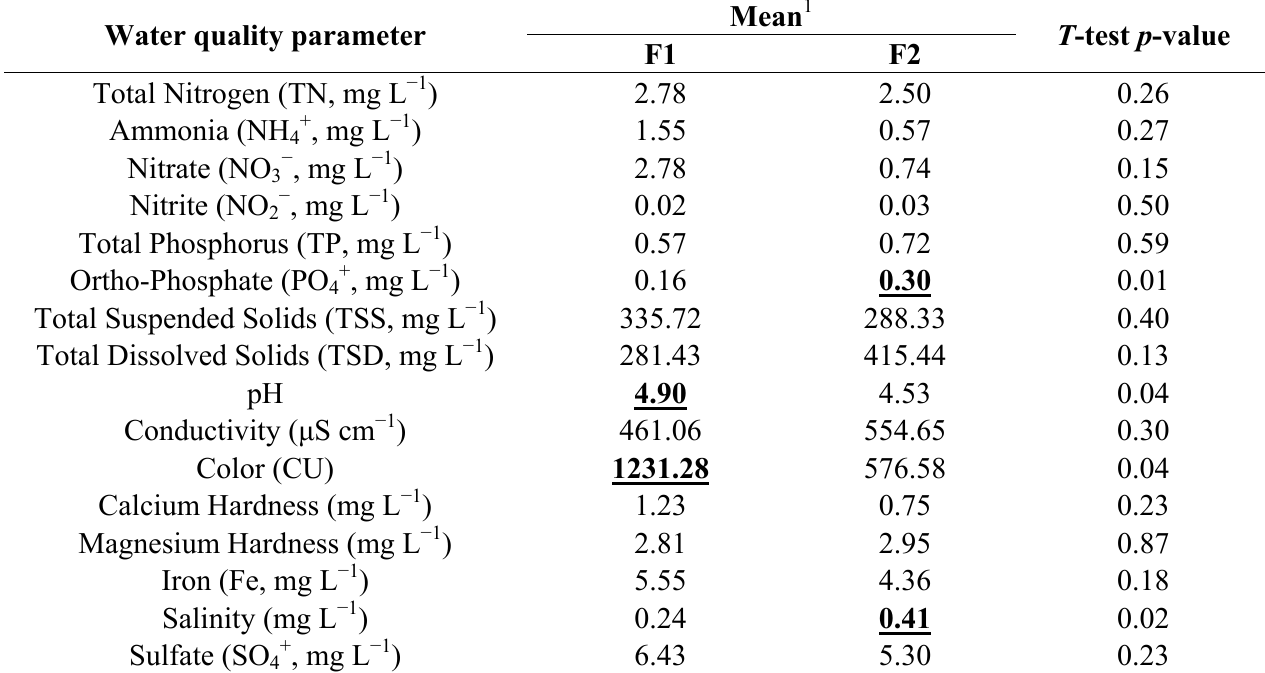
Table 1. Mean concentrations for water quality parameters measured below two natural gas well sites (F1 and F2) from October 2008–March 2010 at the Alto Experimental watersheds in East Texas, USA.